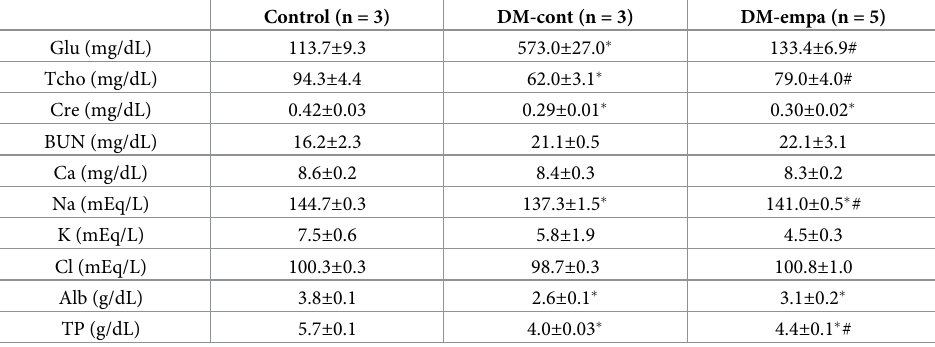
Table 1. Comparison of plasma biochemical parameters between control, DM-cont, and